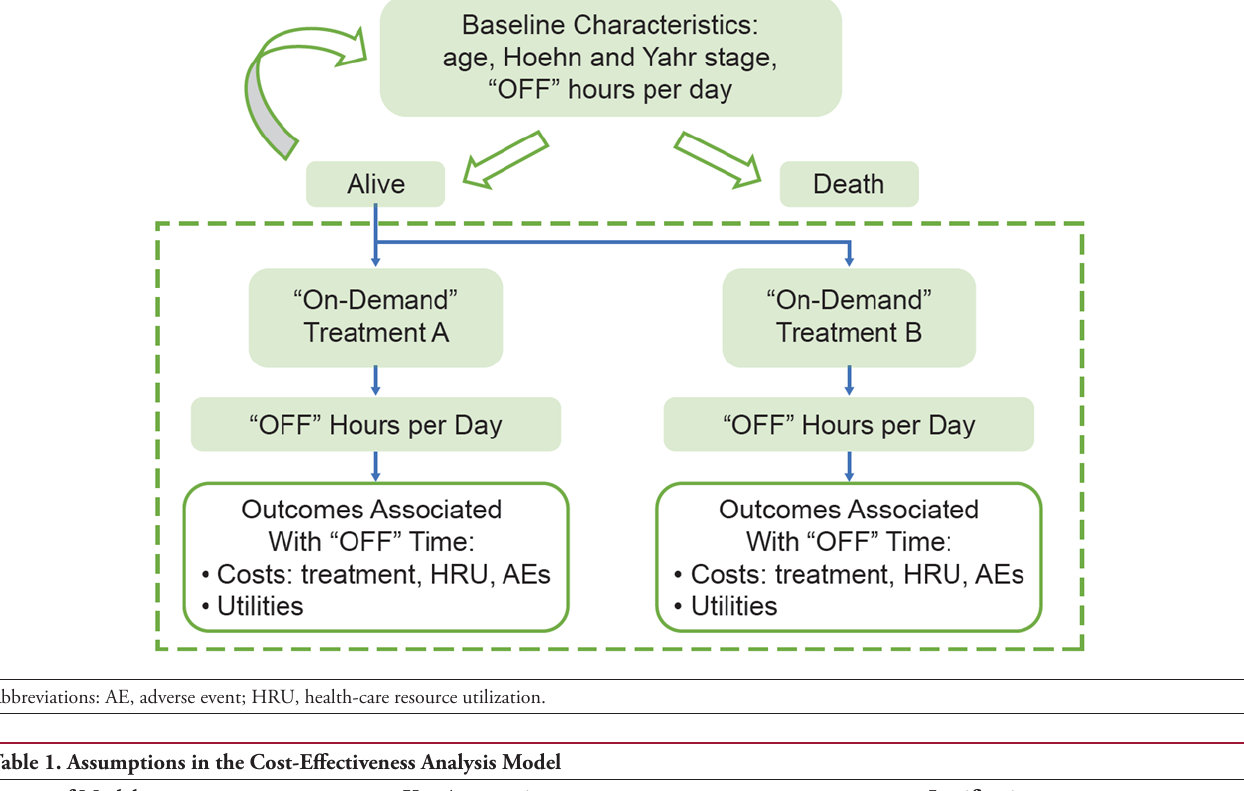
Figure 1. Cost-Effectiveness Analysis Model